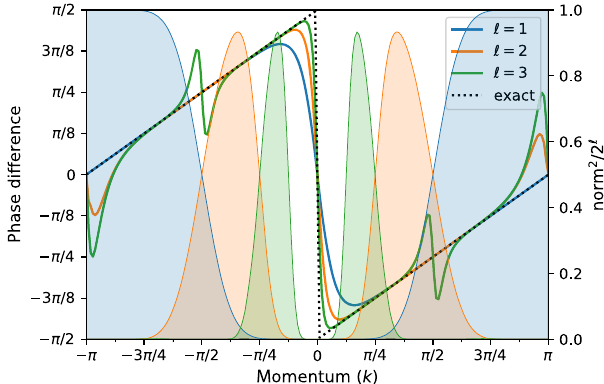
FIG. 2. Fourier spectrum of the outputs of the inverse wavelet transform for levels l ¼ 1 , 2, 3 and wavelet parameters K ¼ 4 , L ¼ 6 . Both filters have equal magnitude in momentum space (shaded regions). The relative phase difference of their Fourier transforms (solid lines) approximates the exact phase difference of the two components of Eq. (3) or, equivalently, of the negative- energy eigenstates of the single-particle Hamiltonian (black dotted